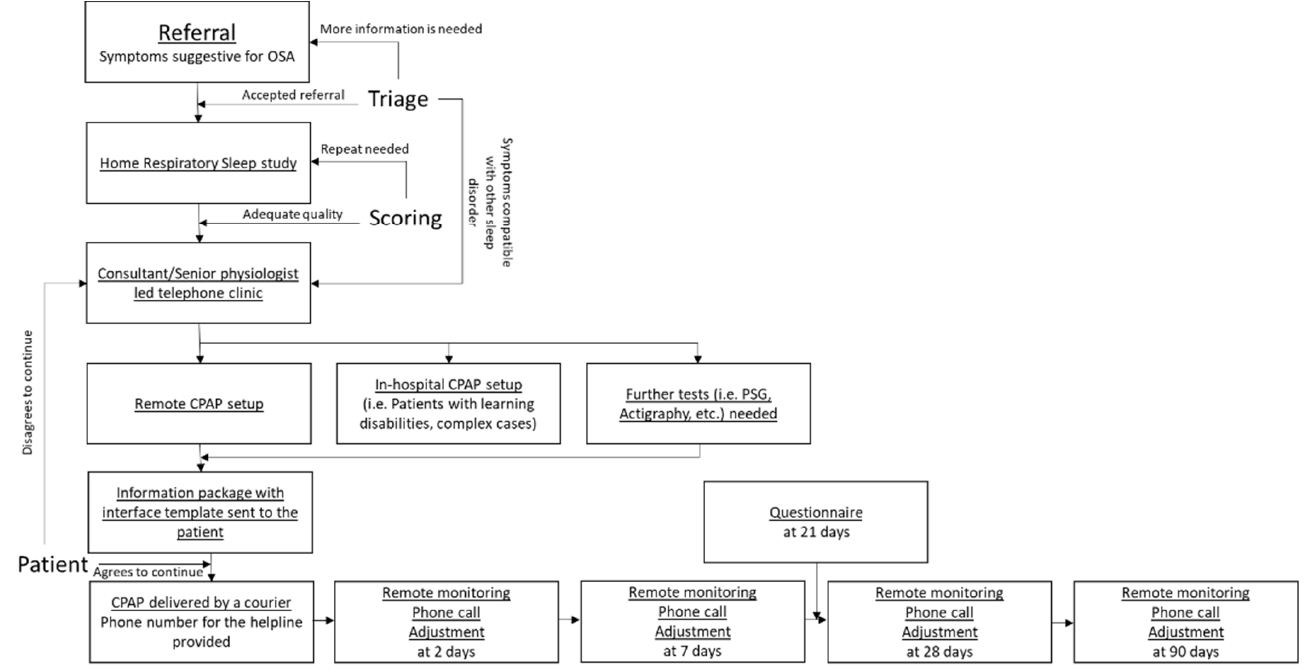
Figure 1. Standard operation protocol for the remote CPAP service. OSA—obstructive sleep apnoea, CPAP—continuous positive airway pressure.